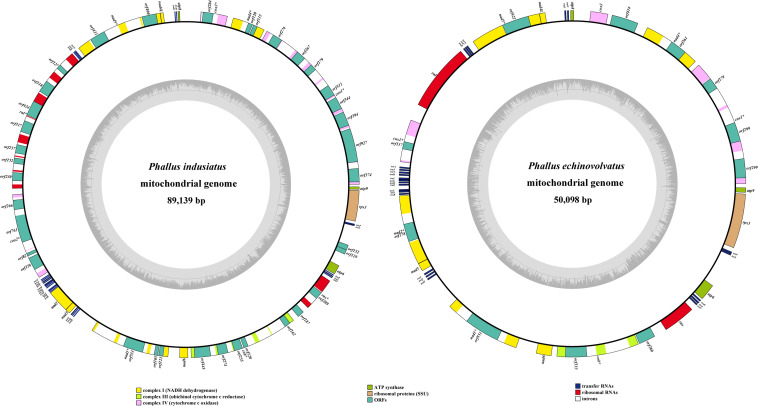
Circular maps of the mitogenomes of two Phallus species. The first nt of the cox1 gene was defined as nt 1 of the genome artificially. Various genes are represented with different color blocks.